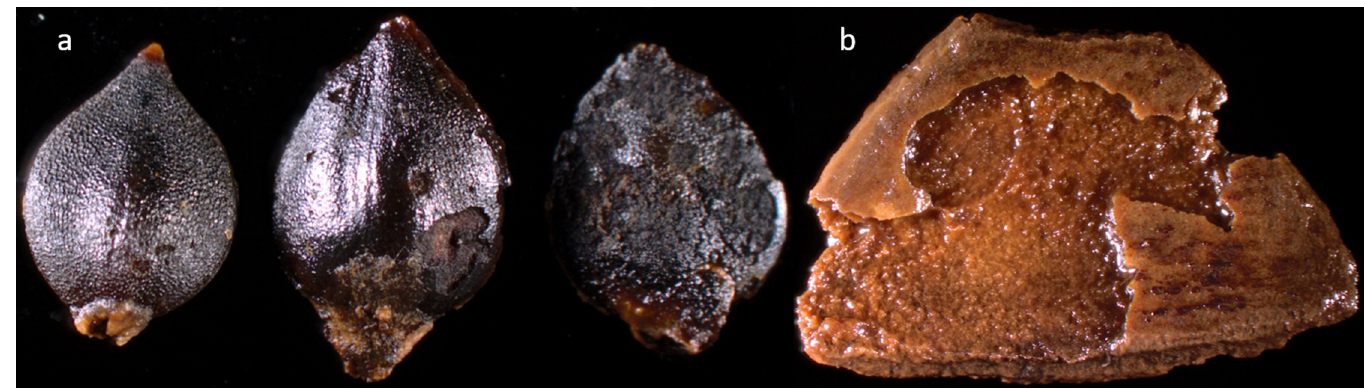
Fig 12. Seeds from water-pepper (a) and hazelnut (b) from trench 209 showing signs of corrosion and etching likely caused by an oxygenated and acidic environment. Photography: Santeri Vanhanen, created for this publication.